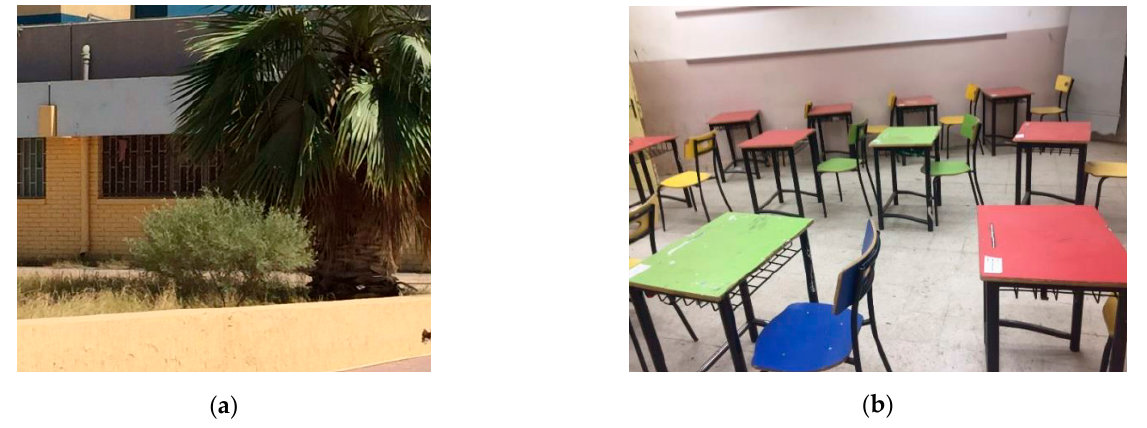
Figure 3. The school classroom modelled in this study, viewed from outside ( a ) and inside ( b ).